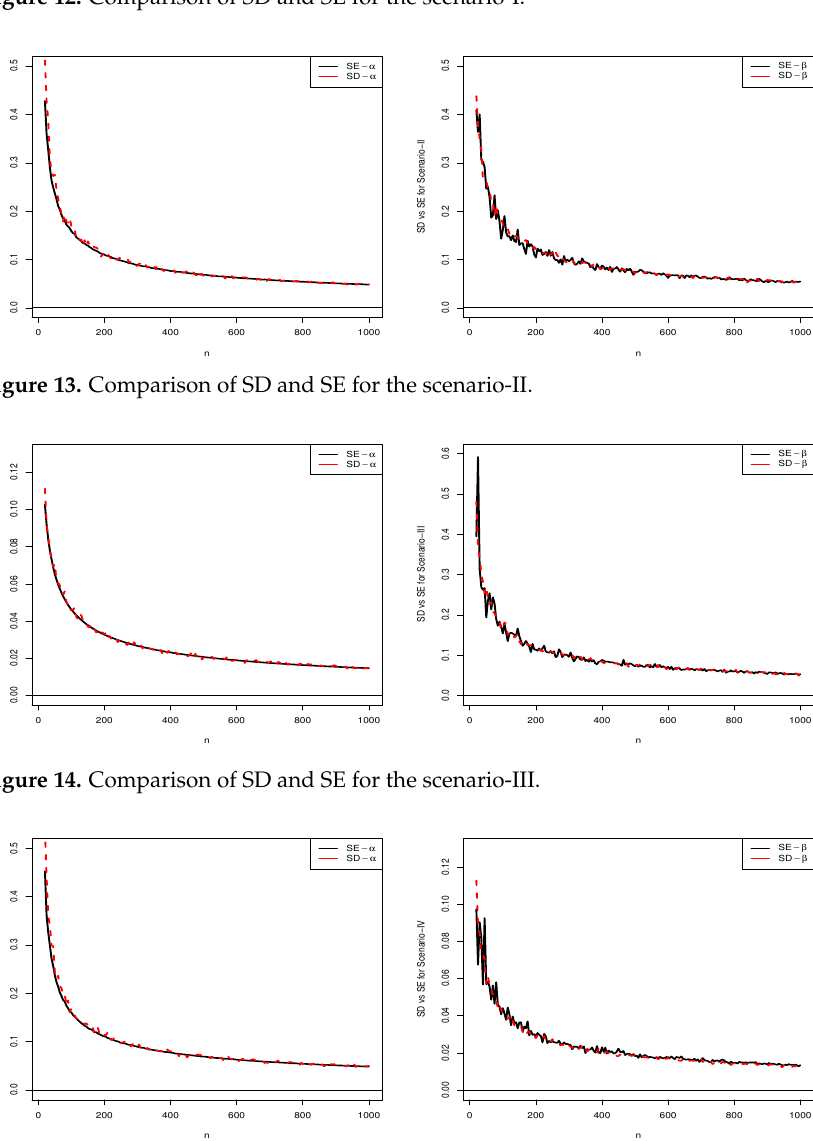
Figure 12. Comparison of SD and SE for the scenario-I.